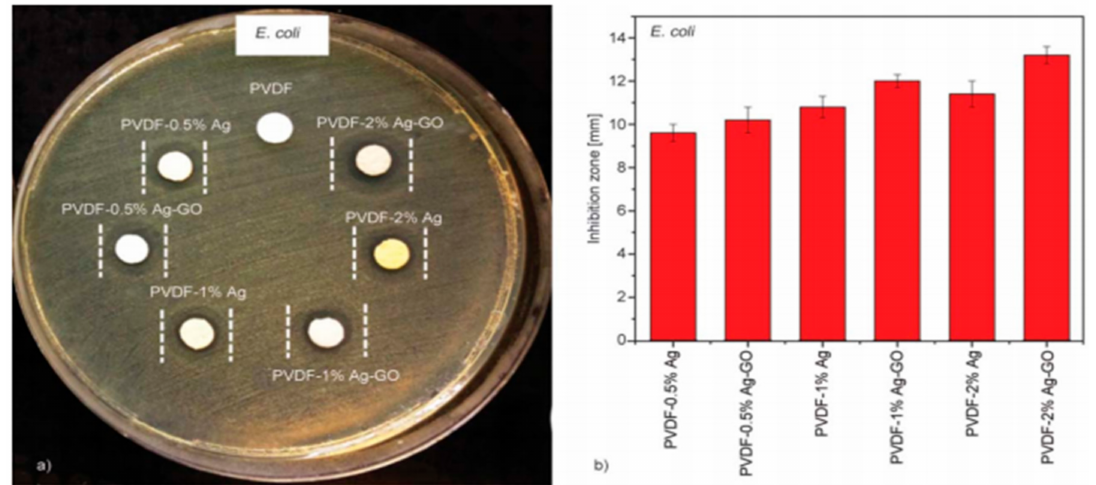
Figure 3. ( a ) Photograph and ( b ) diameter of the zone of inhibition of electrospun PVDF/Ag/GO nanocomposite membranes with different Ag-GO loading exposed to E. coli . GO content was fixed at 1 wt% while the AgNPs contents were kept at 0.5, 1 and 2 wt%. Reprinted with permission from ref. [55]. Copyright 2021 Express Polymer